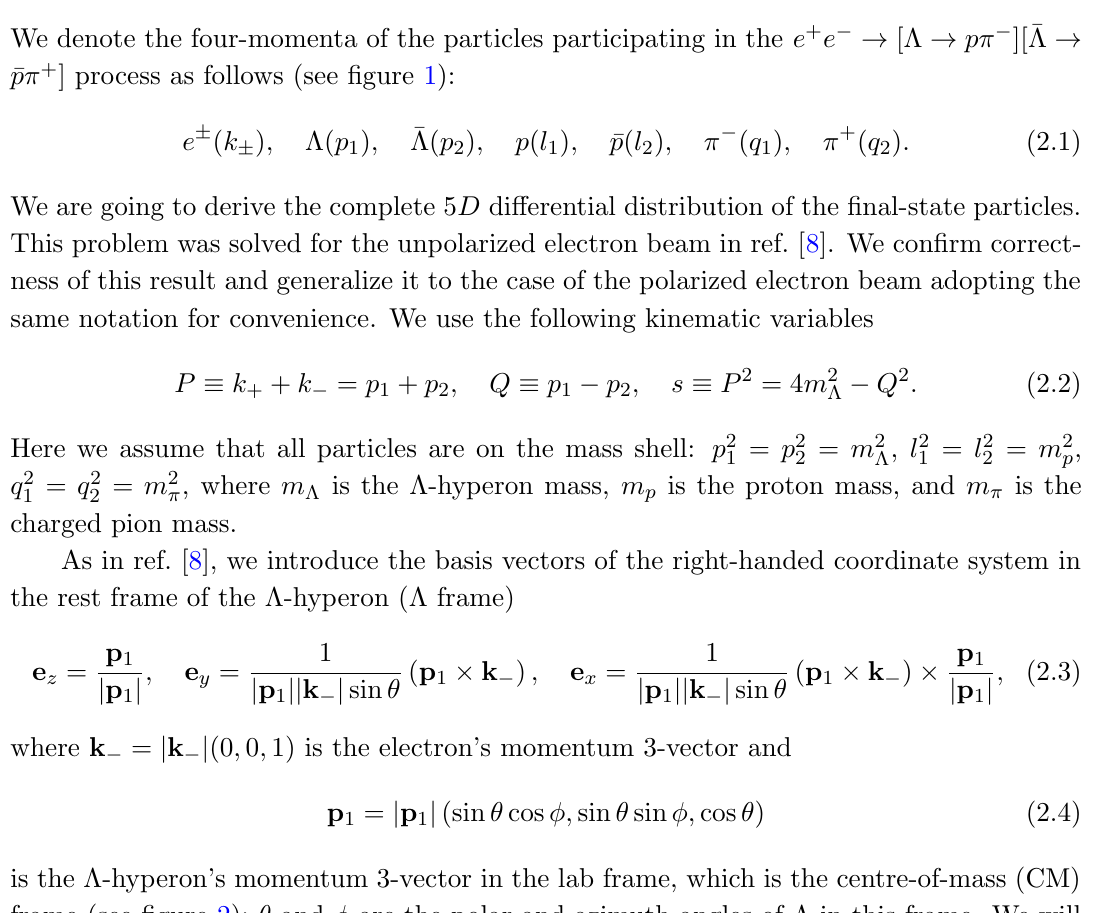
J= [(cid:3) p(cid:25) (cid:0) ][(cid:22)(cid:3) ! ! !